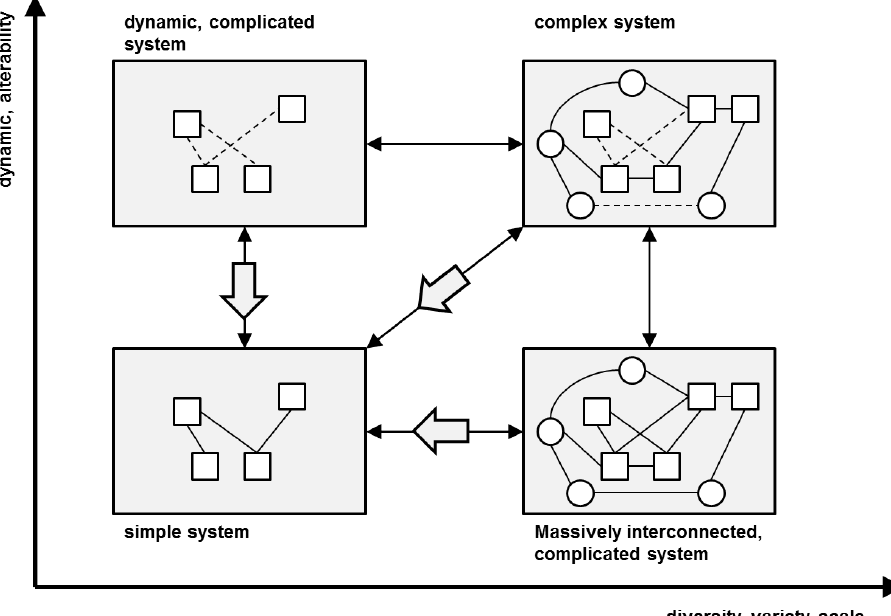
Figure 1. Classification of system types